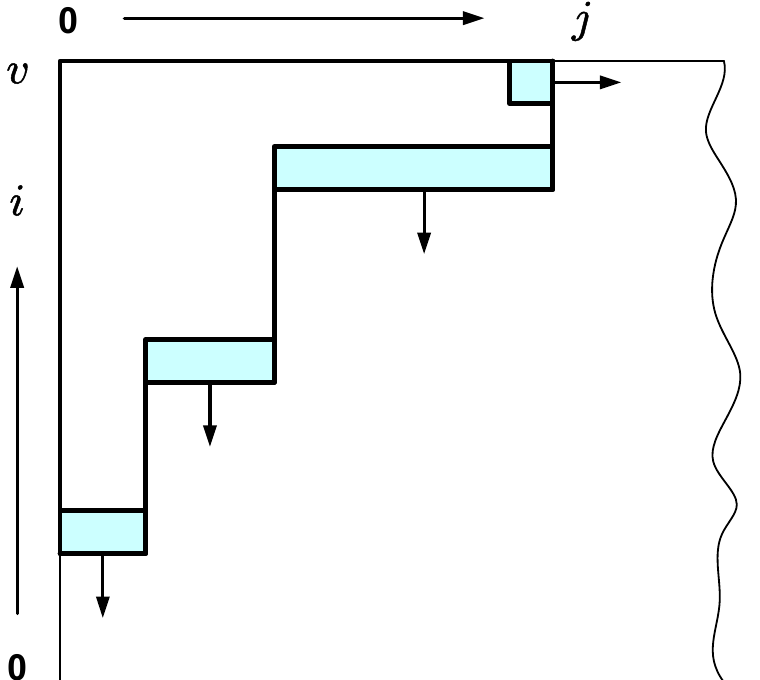
Figure A2. Accepted form of truncated state space. Arrows indicate the directions in which the initial process r ( t ) can leave the considered truncated state space. The border states are